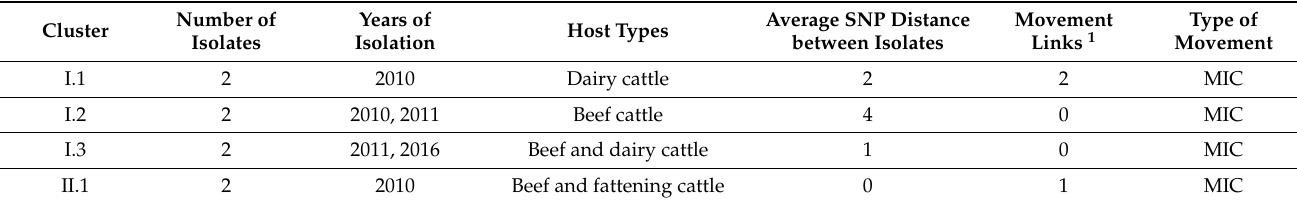
Table 3. Putative transmission clusters identified from WGS and SNP analysis of 125 M. bovis isolates obtained from livestock and wildlife in Catalonia, Spain, from 2008 to 2018. SNP distance is represented as an average of the SNP distances for each of the isolates involved in a